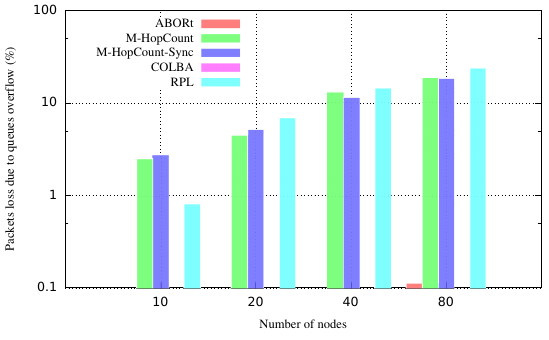
Figure 6. Queue overflow ratio for 5